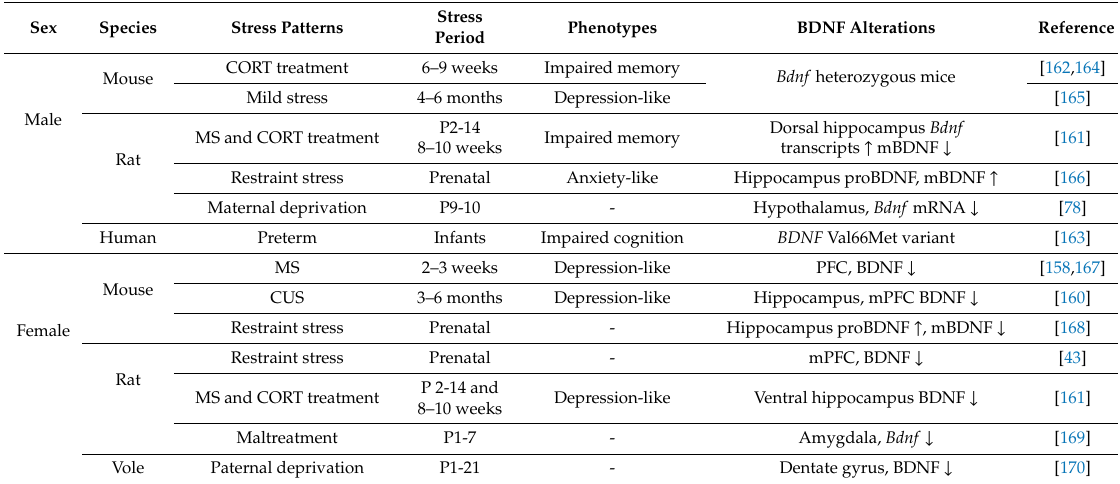
Table 3. Summary of sex-specific modification on BDNF